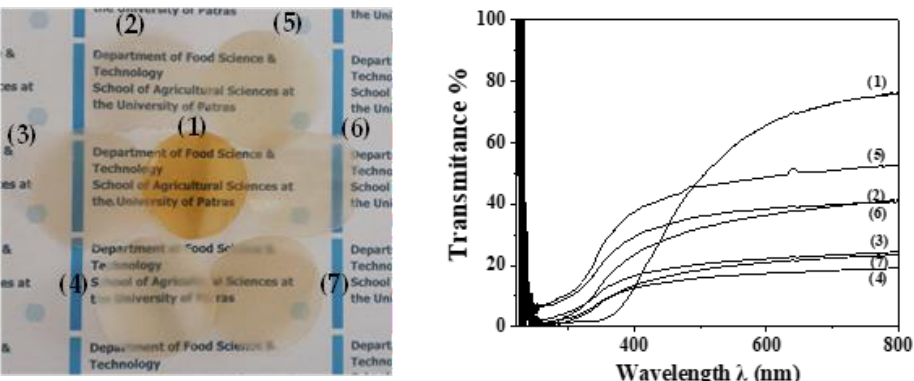
Figure 9. ( a ) photo images and ( b ) UV-vis transmittance plots of (1) pure CS/PVOH films, (2) CS/PVOH/5HNT, (3) CS/PVOH/10HNT, (4) CS/PVOH/15HNT, (5) CS/PVOH/5TO@HNT, (6) (2) CS/PVOH/5HNT, (3) CS/PVOH/10HNT, (4) CS/PVOH/15HNT, (5) CS/PVOH/5TO@HNT, CS/PVOH/10TO@HNT, and (7) CS/PVOH/5TO@HNT films. (6) CS/PVOH/10TO@HNT, and (7) CS/PVOH/5TO@HNT films.